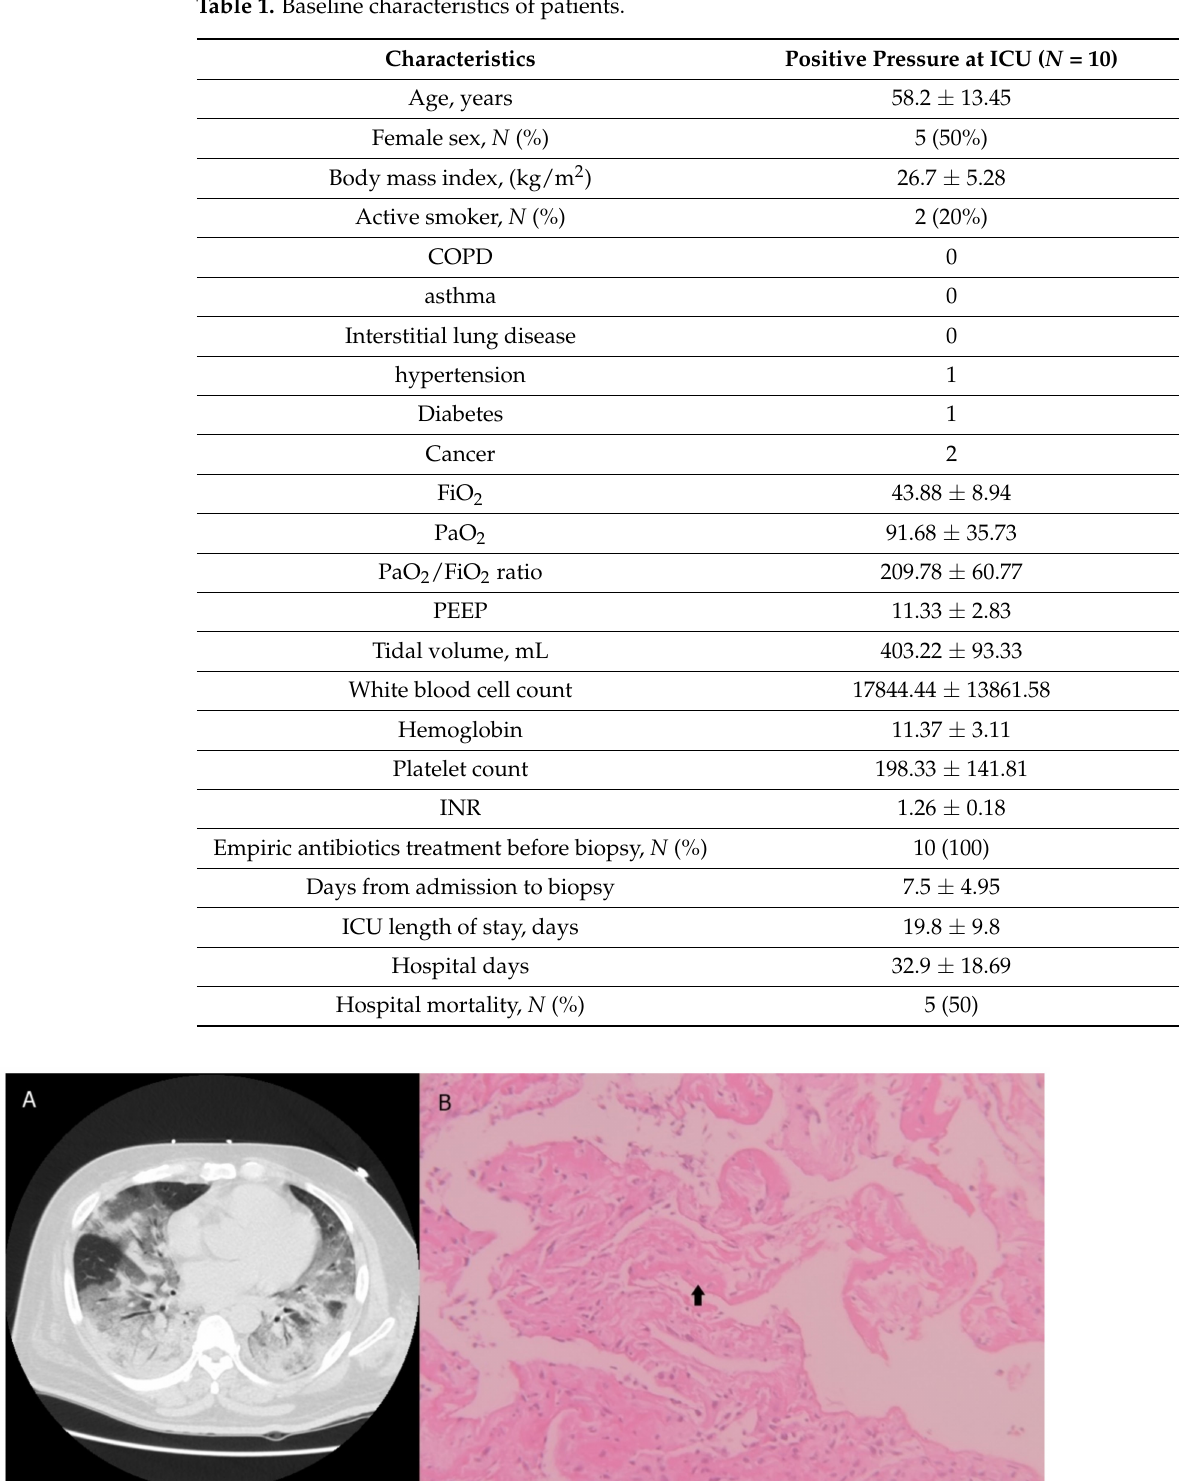
Table 1. Baseline characteristics of patients.